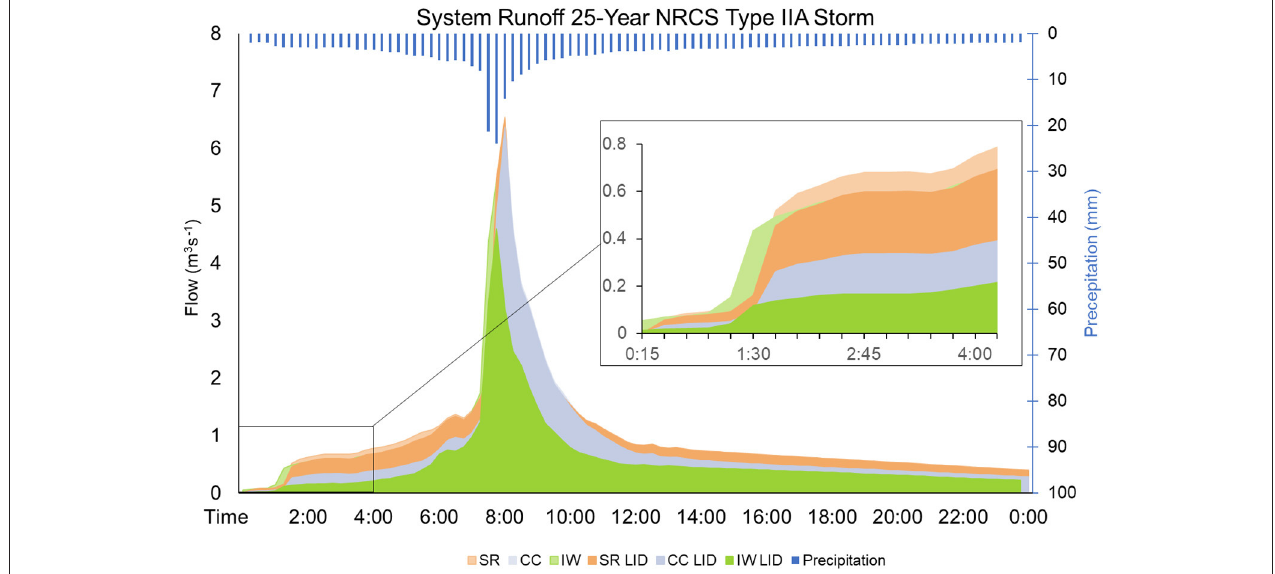
FIGURE 4 | Results of SWMM simulation for the 25-year design storm illustrating the lower peak flows associated with the IW future, and high peak flows in the SR future.